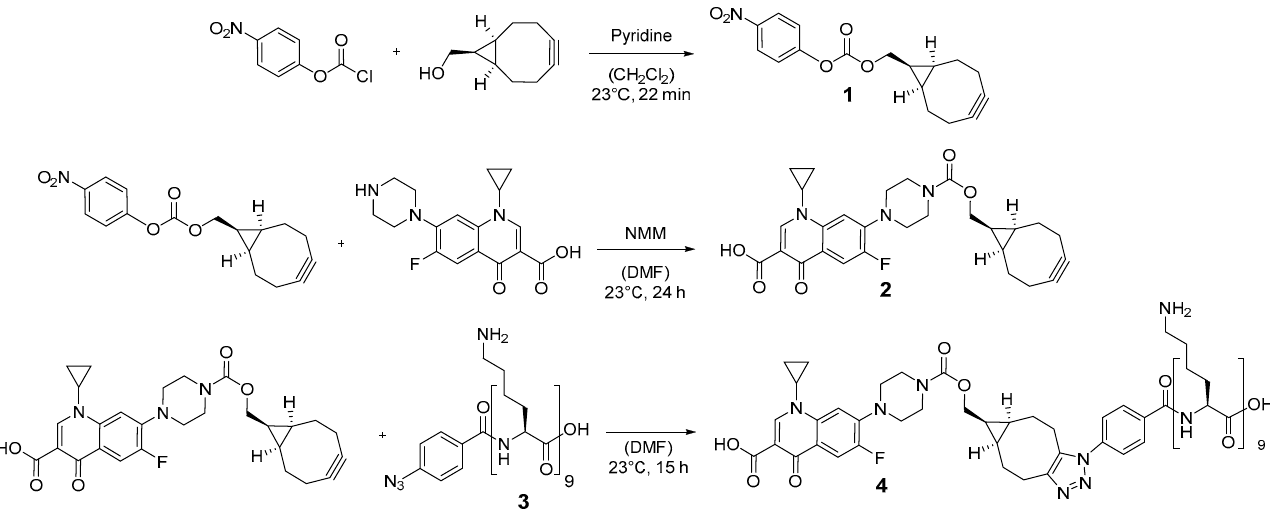
Figure 1. Reaction scheme for the preparation of ciprofloxacin conjugated to a poly- L -lysin sequence which can be used as linker.